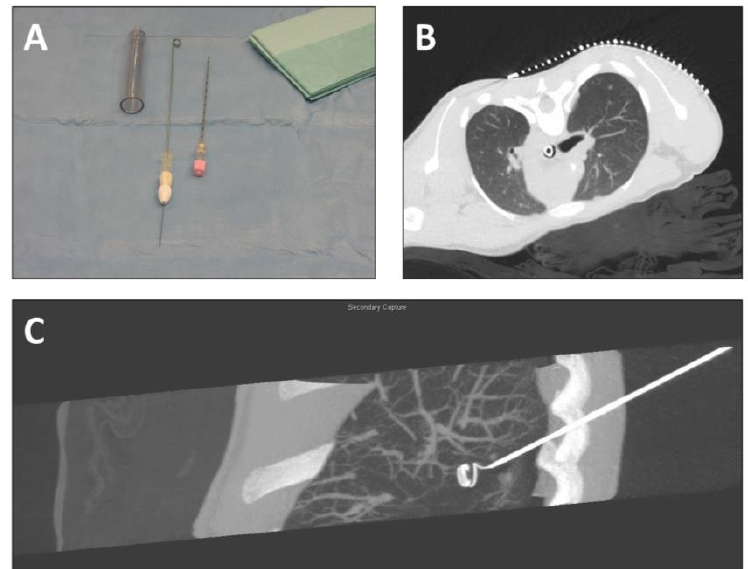
Figure 1. CT-guided labeling of lung nodules before thoracoscopic resection. ( A ) Equipment for labeling (introducing cannula with drawn-in wire, puncture needle); ( B ) localizing CT-scan (axial plane) with localization grid placed on the thorax above the intrathoracic nodule; ( C ) reconstruction of CT scan (sagittal plane) after coil wire placement.